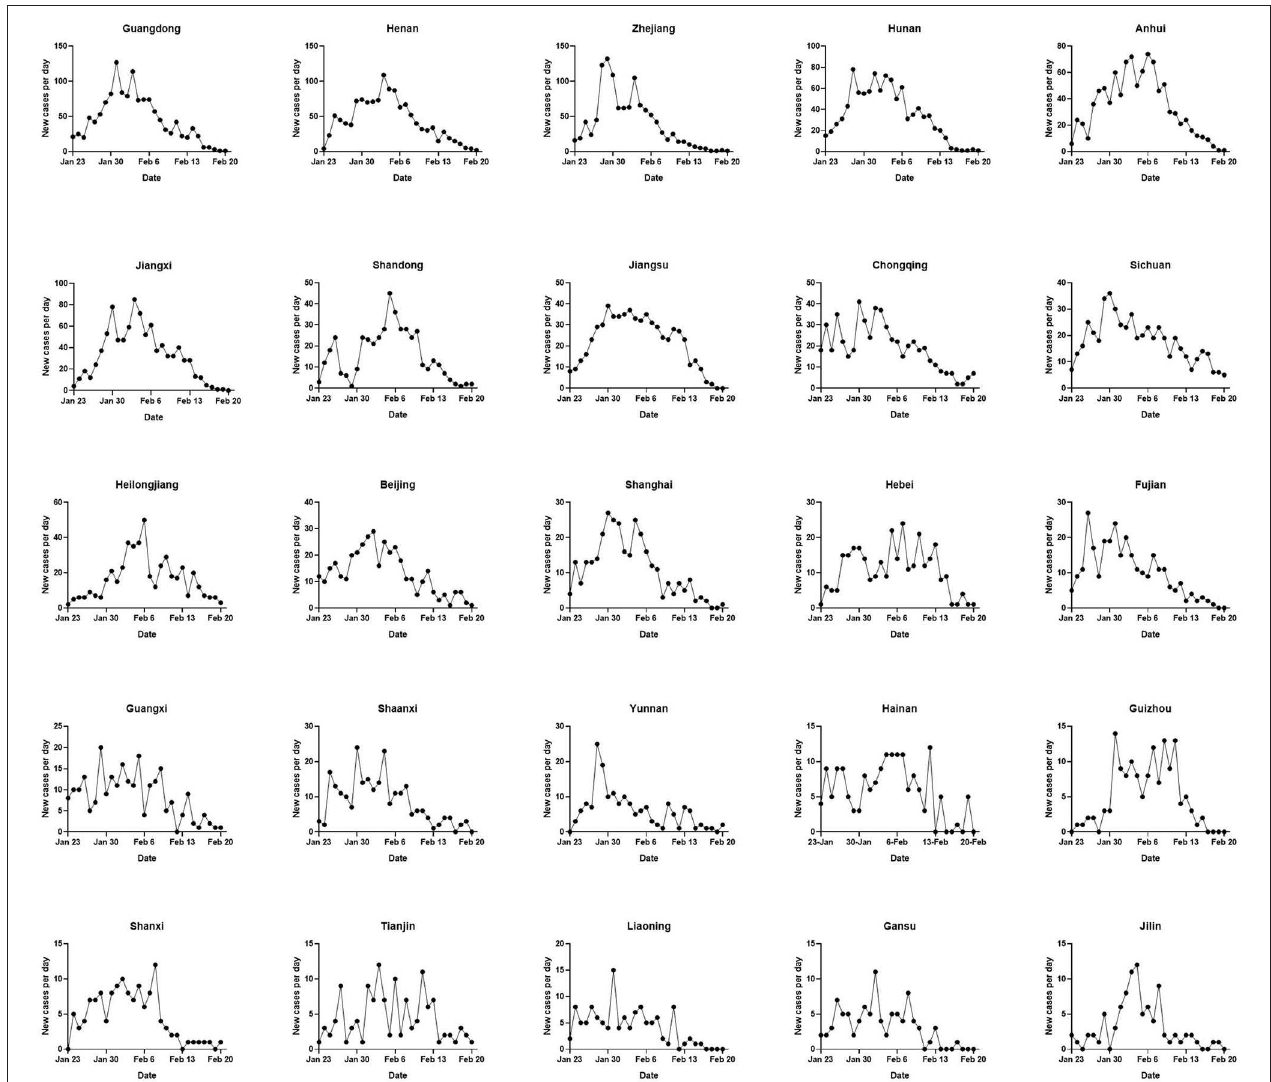
FIGURE 3 | The trends of daily new confirmed cases in the top 25 provincial units in terms of the total cases over 90 were presented (the trend of Hubei has been presented in Figure 2B ), including Guangdong, Henan, Zhejiang, Hunan, Anhui, Jiangxi, Shandong, Jiangsu, Chongqing, Sichuan, Heilongjiang, Beijing,